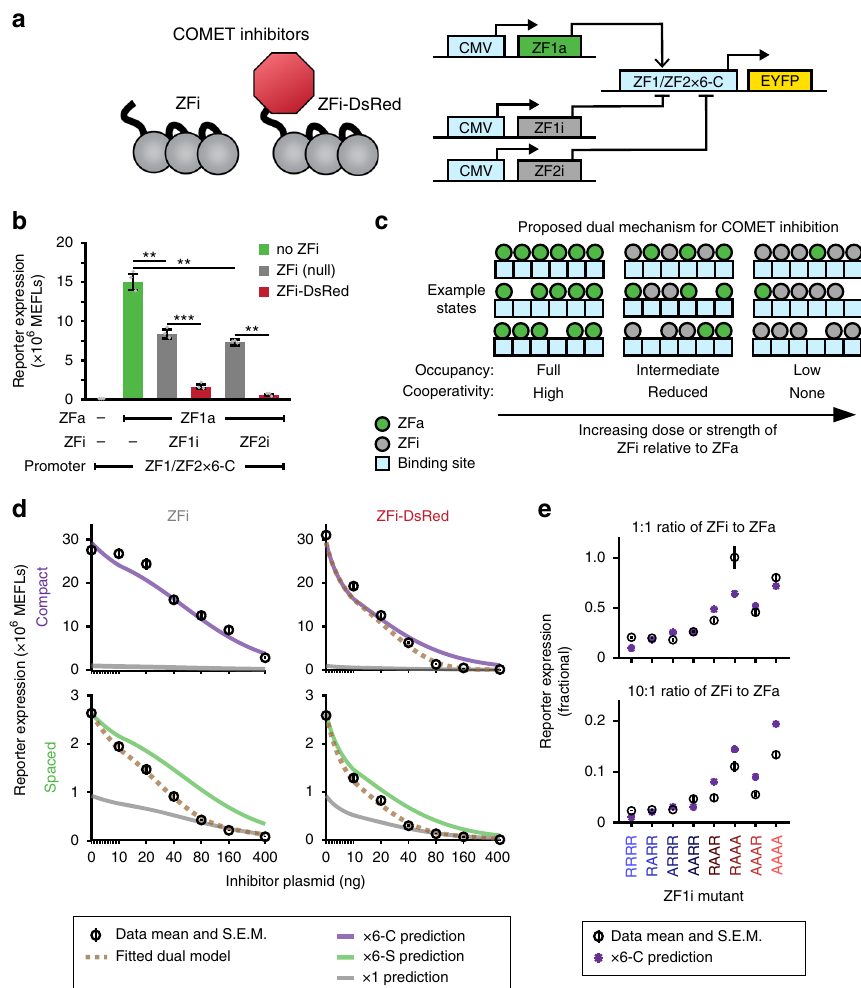
Fig. 5 Transcriptional inhibition. a The schematic depicts two types of inhibitors that were evaluated. A ZF1/ZF2x6-C hybrid promoter is activated by ZF1a and inhibited by ZF1i or ZF2i. b ZFi and ZFi-DsRed differentially inhibit transcription (one-tailed Welch ’ s t -test: ** p < 0.01, *** p < 0.001). c The cartoon summarizes the proposed conceptual model of ZFi-mediated inhibition. Within each cell, a promoter can occupy states with different con fi gurations of ZFa and ZFi. Several example states are shown for three conditions of increasing dose or strength of inhibitor (i.e., DNA-binding af fi nity) relative to activator. d ZFi and ZFi-DsRed differ from standard competitive inhibitors. Predictions for competitive inhibition alone, for various promoter con fi gurations, are depicted with solid lines (Methods). COMET inhibitors track the dotted lines, which represent fi ts to the dual mechanism model, except in the case of ZFi paired with x6-C, which tracks the competitive inhibition-only prediction. Each condition uses ZF1a at a dose of 40 ng. X -axes are scaled linearly from 0 to 10 ng and logarithmically above 10 ng. e Measured and predicted reporter expression were compared for a panel of ZFi mutants. Each condition uses ZF1a (RAAR) at a dose of 40 ng and the ZF1x6-C compact promoter. Experiments were conducted in biologic triplicate, and data were analyzed as described in Methods. Error bars represent the S.E.M. Source data are provided in the Source Data fi